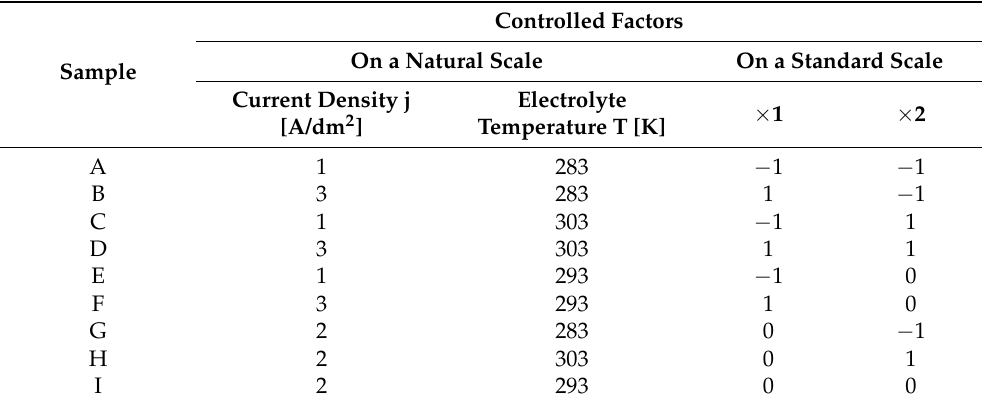
Table 2. Total experiment